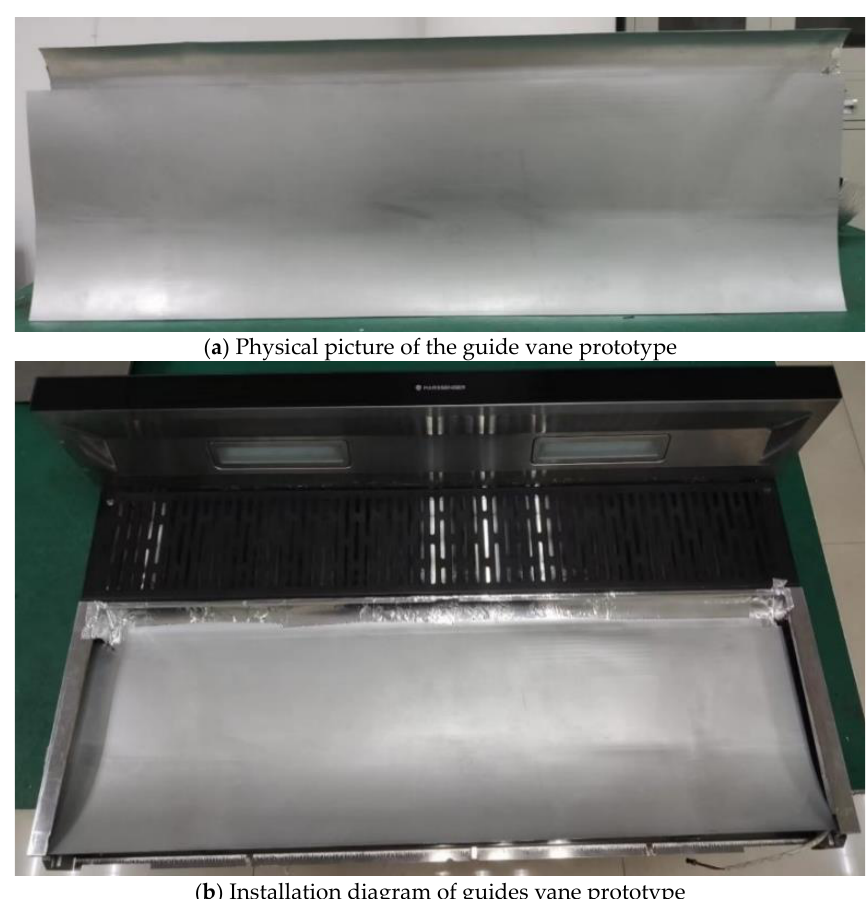
Machines 2023 , 11 , x FOR PEER REVIEW Figure 23. Diagram of guide vanes prototype. Figure 23. Diagram of guide vanes prototype.